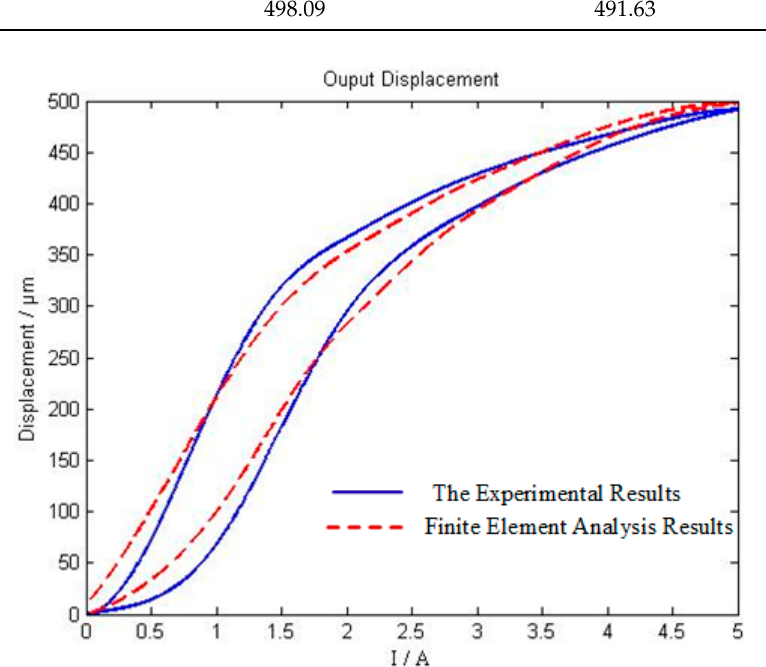
Figure 12. Contrast diagram of hysteretic loop between experiment and finite element analysis. Table 1. Comparison between the finite element model analysis and experimental results.